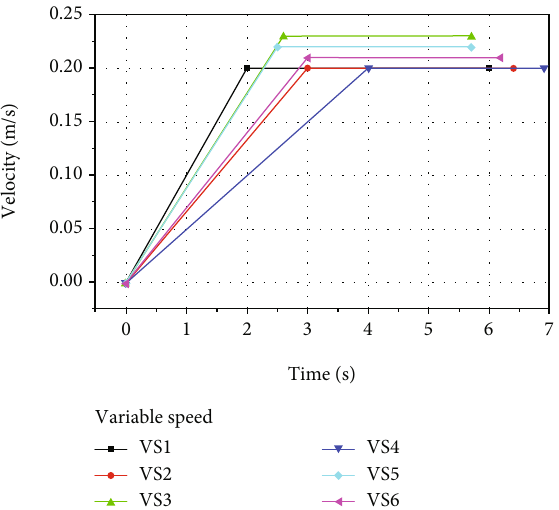
Figure 11: The type of moving speed.